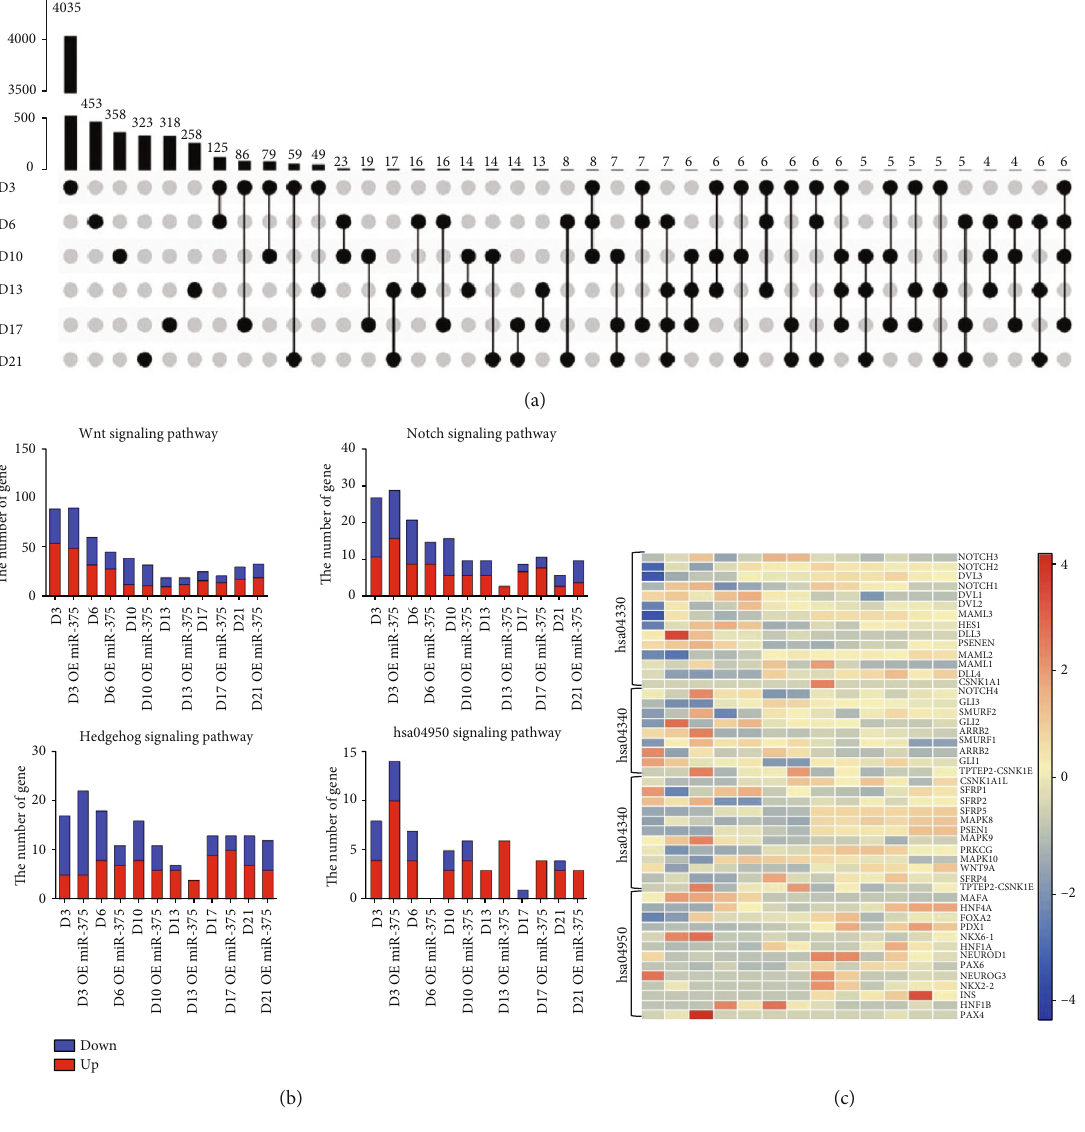
Figure 5: Interaction of genes related to pancreatic di ff erentiation. (a) The number of di ff erential genes obtained by comparing miR-375 with its corresponding control group after overexpression at di ff erent stages. (b) The number of genes that overexpressed miR-375 has changed signi fi cantly compared with its corresponding control group in di ff erent signaling pathways. Blue represents decreased expression, and red represents increased expression. (c) The heatmap shows the expression of important transcription factors in di ff erent pathways in the OE group and the control